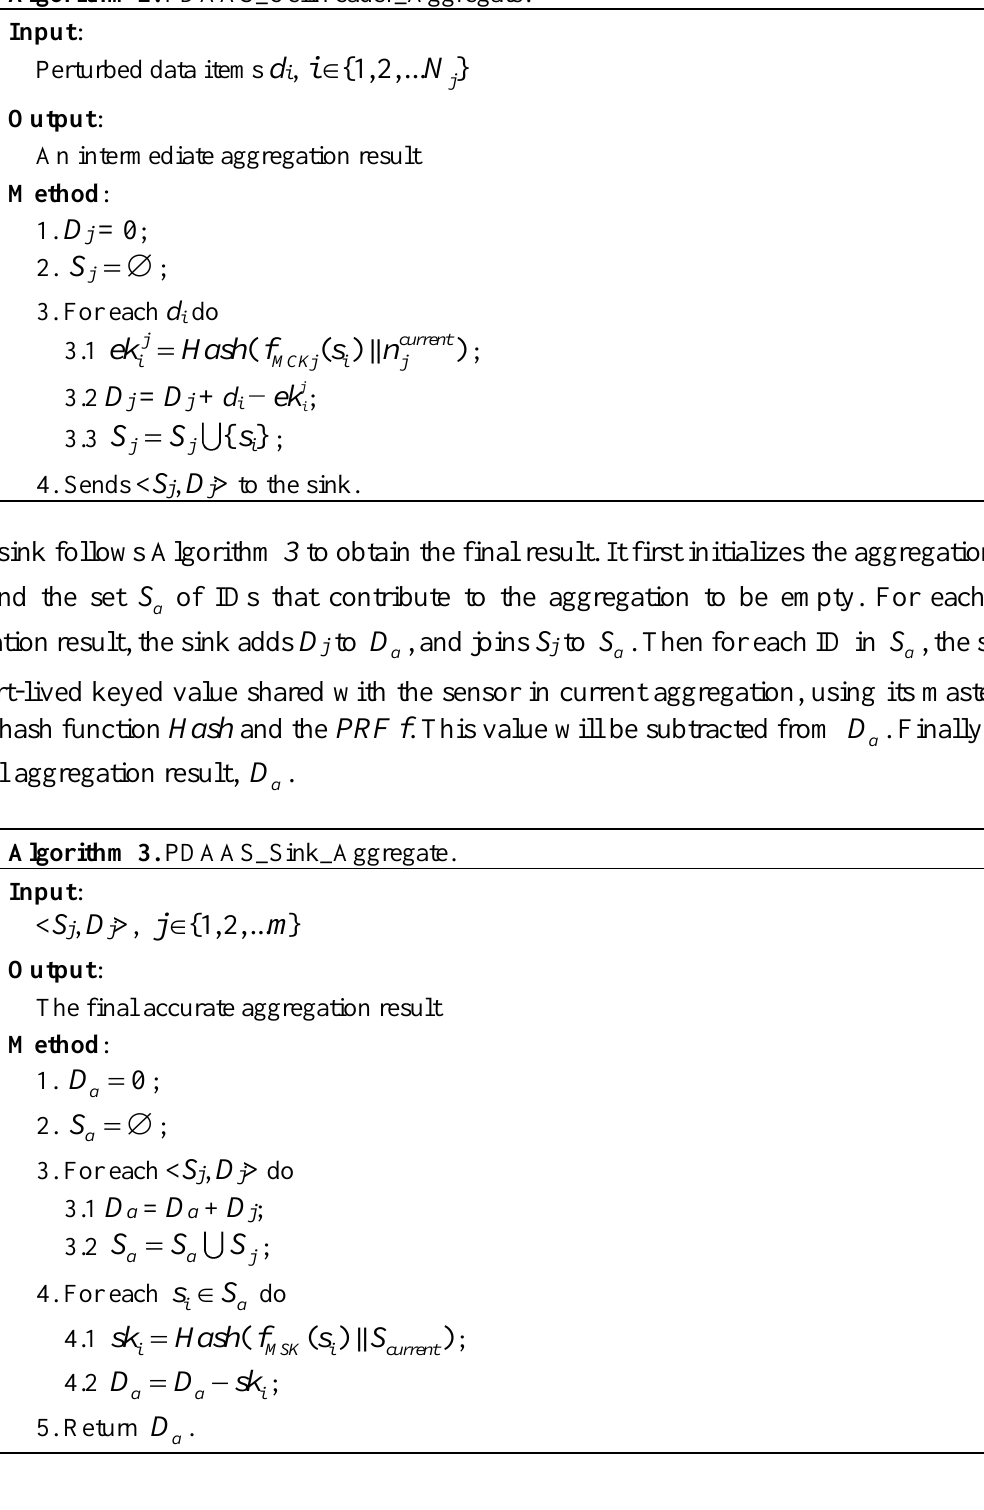
Algorithm 2. PDAAS_CellHeader_Aggregate.